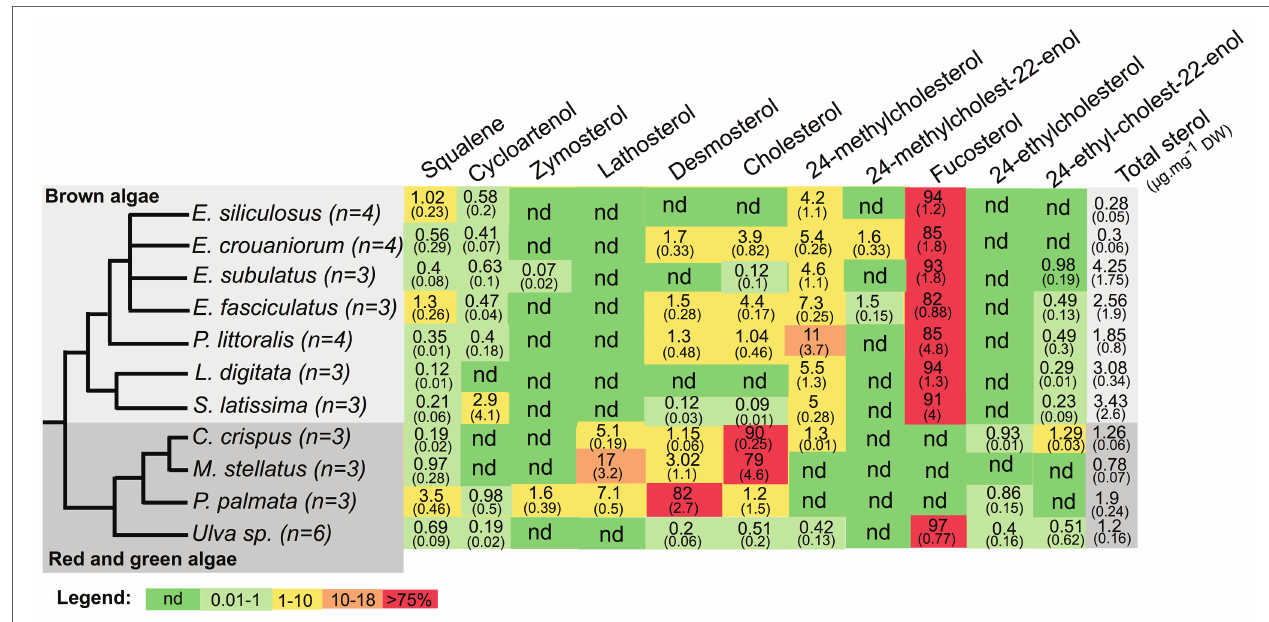
FIGURE 1 | Relative abundances of squalene and sterols detected in algal samples measured by semi-quantitative gas chromatography-mass spectrometry (GC- MS) profiling. Relative abundance values are expressed as a percentage of total sterol content, mean of multiple replicates, with SD in brackets. “nd” means not detectable (<0.01%). The tree represents the consensus view of the species phylogeny, with number of biological replicates indicated for each species. Last column (in gray) indicates the abundance of sterols relative to dry weight